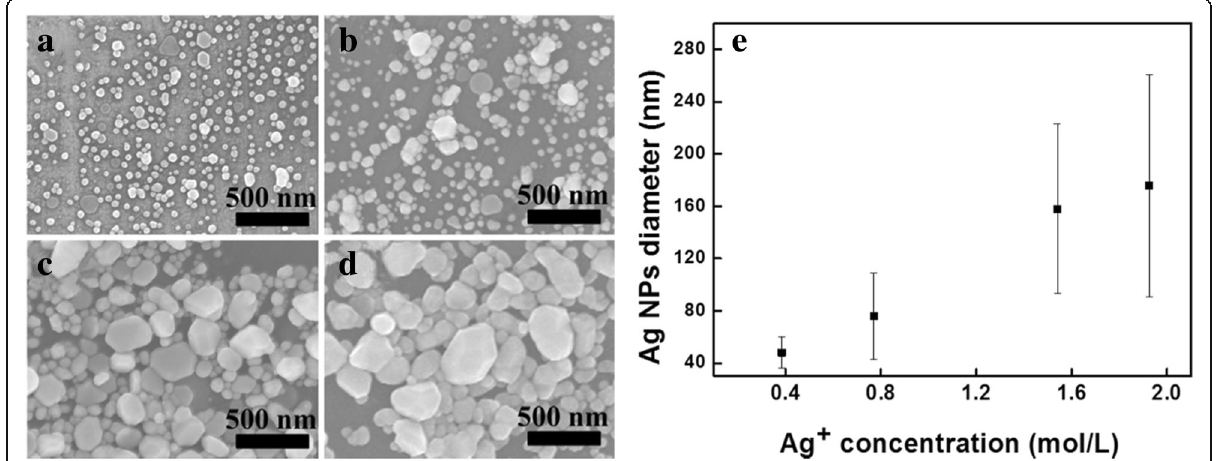
Fig. 2 SEM images of the synthesized Ag NPs with different size distributions by adjusting the Ag + concentration in reaction. a Ag + 0.385